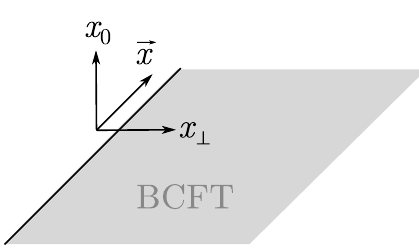
Figure 2. A BCFT on a half-plane R d − 1 × R + . Here, x 0 and ~x are coordinates parallel to the boundary; x is a coordinates perpendicular to the planar boundary, which sits at x ⊥